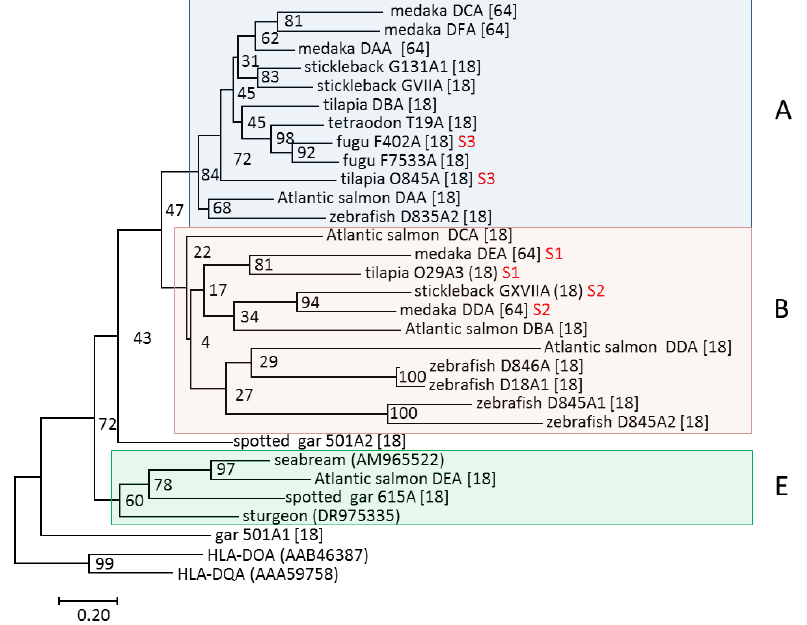
Figure 6. Phylogeny of MHC class II alpha 1 domain sequences modified from Dijkstra et al. [18]. Individual lineages are shown on the right hand side of each shaded clade. Neoteleost genes residing within the three syntenic regions S1–S3 are shown using red font. The bootstrap consensus tree was inferred from 1000 replicates, is drawn to scale, and has branch lengths representing the number of amino acid substitutions per site (see scale bar). The tree is rooted using the human MHC class II sequences HLA-DQA and HLA-DOA. GenBank sequence references are in parenthesis while the remaining sequences can be found in